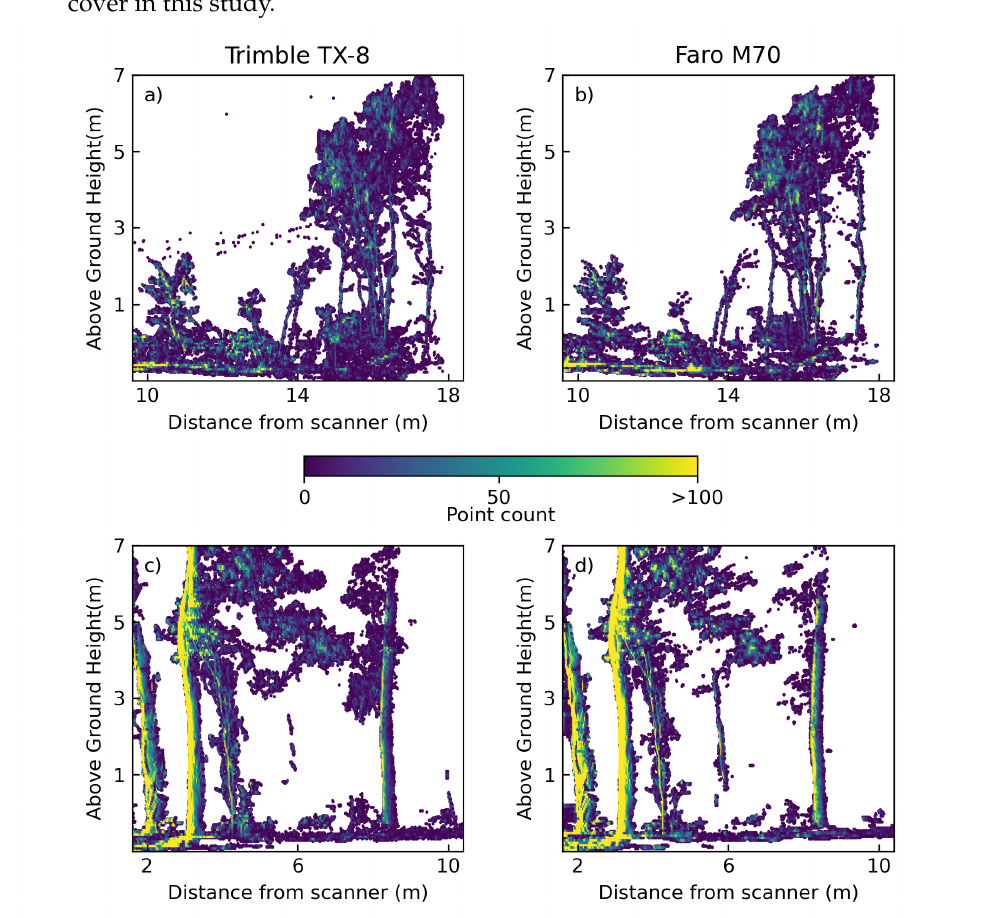
Figure 6. Examples of the characteristic noise in ( a , c ) Trimble TX8 and ( b , d ) Faro M70 scans. Panel ( a ) shows several isolated noise points between 2 and 6m from the scanner and at a height of 2 to 3m. Panel ( d ) shows the characteristic noise of the Faro scanner where noise extends in the direction of the emitted laser prior to the